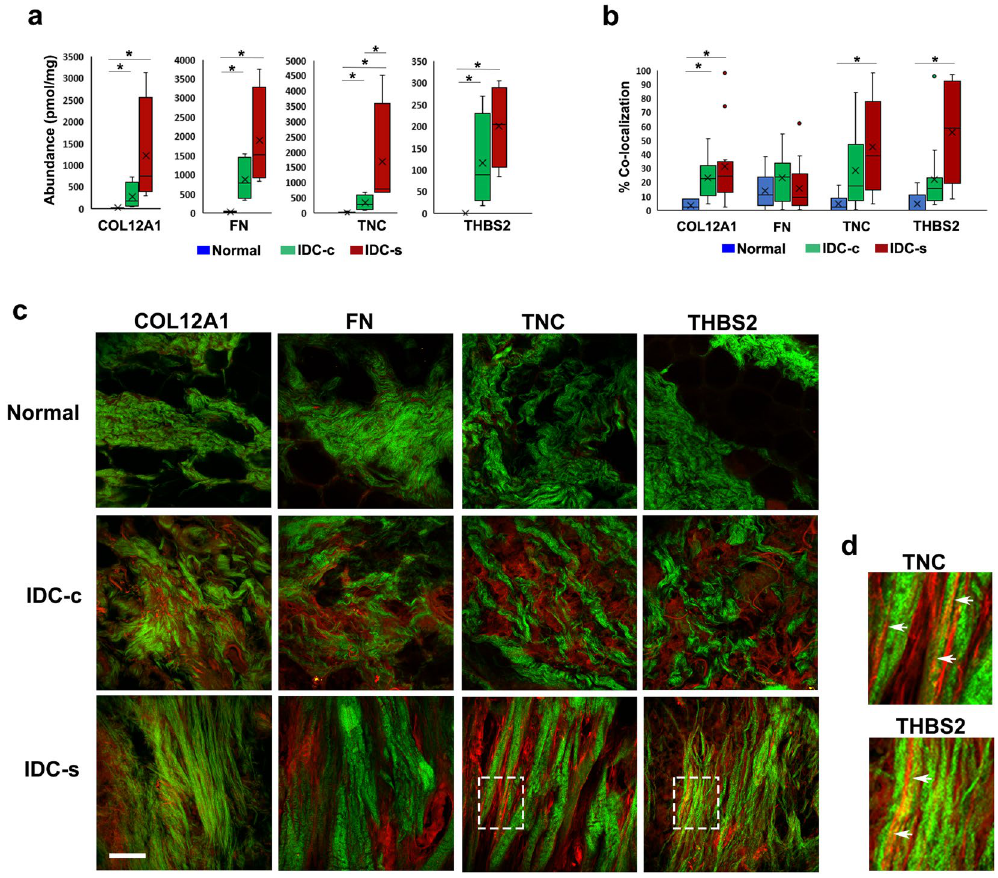
Figure 4. Co-localization of aligned collagen fibers with THBS-2 and TNC in normal breast and IDC-s patient tissues. ( a ) Concentrations from quantitative LC-MS/MS analysis for collagen XII, fibronectin, thrombospondin-2, and tenascin-C. All four proteins are increased in abundance in IDC-c and IDC-s compared to normal tissue. Error bars represent sample variance, X represents the mean concentration. * p ≤ 0.05. Normal breast, n = 5; IDC-c and IDC-s, n = 4. Representative, single-plane images of collagen SHG and immunostained ECM proteins in different portions of the same patients’ tissues used for LC-MS/MS. ( b ) Quantifications of percent-area fluorescence within the masked-area of collagen SHG. A minimum of six ROI’s from each patient sample were used for co-localization analysis. * Indicates p < 0.05. ( c ) Multiphoton images of COL12A1, FN, TNC, and THBS-2 (red) with collagen SHG (green) from normal, IDC-c and IDC-s patient samples. COL12A1 significantly co-localized with IDC-c and IDC-s collagen, however it did not appear organize specifically along collagen fibers. Tenascin-C, TNC shows an increase in co-localization with only with collagen fibers in IDC-s tissues. Similarly, thrombospondin-2, THBS-2, staining is co-localized with fibrillar collagen in IDC-s samples. Scale bar = 50 µ m. ( d ) Magnified Insets (white boxes on IDC-s TNC and THBS2 images from panel c) of straight collagen fiber (green) co-localization with TNC or THBS2 (red). Arrowheads indicate regions of co-aligned collagen and ECM protein